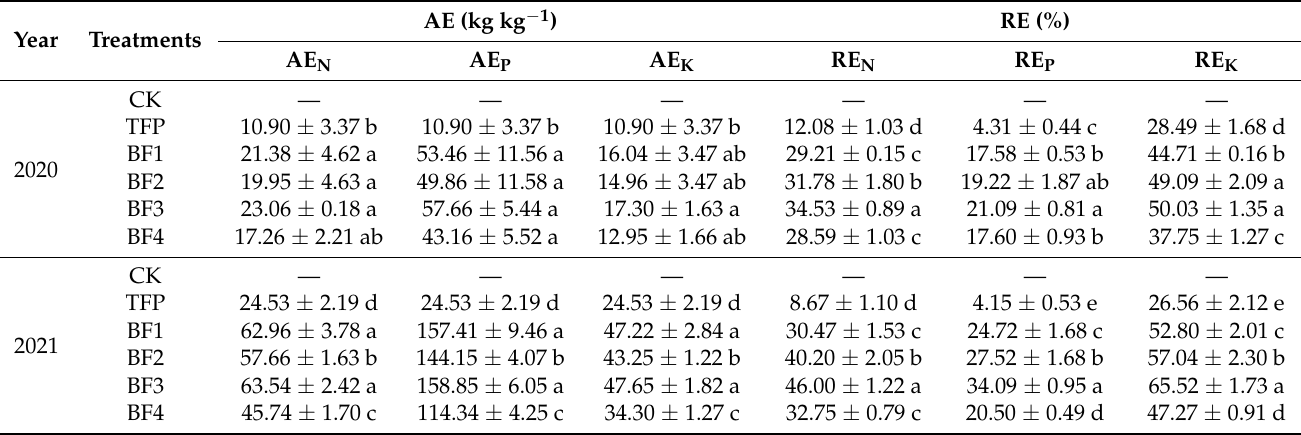
Table 3. Effects of BF on agronomic efficiency and recovery efficiency in 2020 and 2021.